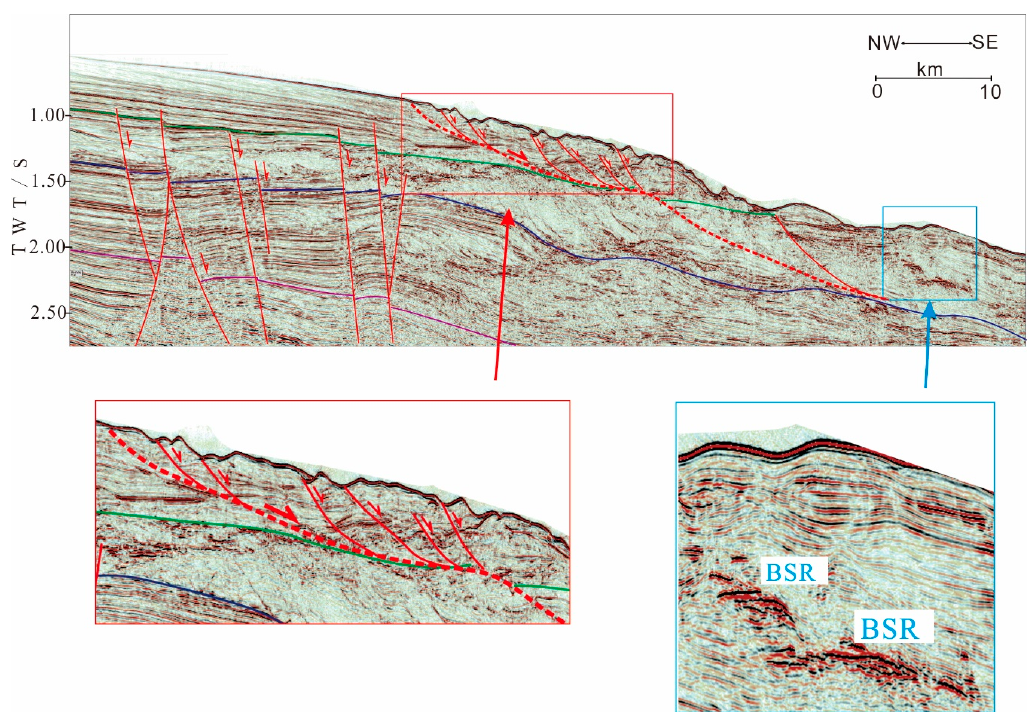
Figure 10. Seismic reflection of Line 9 is a landslide with hydrate located inside its body.